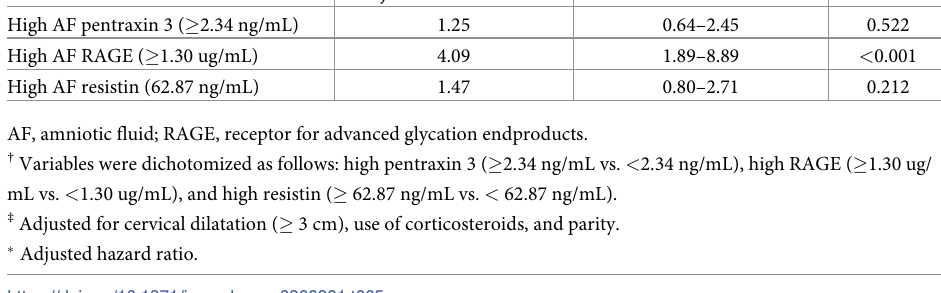
Fig 3. Kaplan-Meier survival estimates of the cerclage-to-delivery interval for (A) AF pentraxin 3 of � 2.34 or < 2.34 ng/mL (median, 26.00 days [95% CI, 0.00–56.13] vs. 97.00 days [95% CI, 90.79–103.21]; P = 0.286), (B) AF resistin of � 62.87 or < 62.87 ng/mL (median, 26.00 days [95% CI, 0.00–59.77] vs. 97.00 days [95% CI, 76.59–117.40]; P = 0.048), and (C) AF RAGE of � 1.30 or < 1.30 μ g/mL (median, 26.00 days [95% CI, 0.00–65.13] vs. 111.00 days [95% CI, 89.02–132.98]; P < 0.001). AF, amniotic fluid; CI, confidence interval; RAGE, receptor for advanced glycation endproducts.